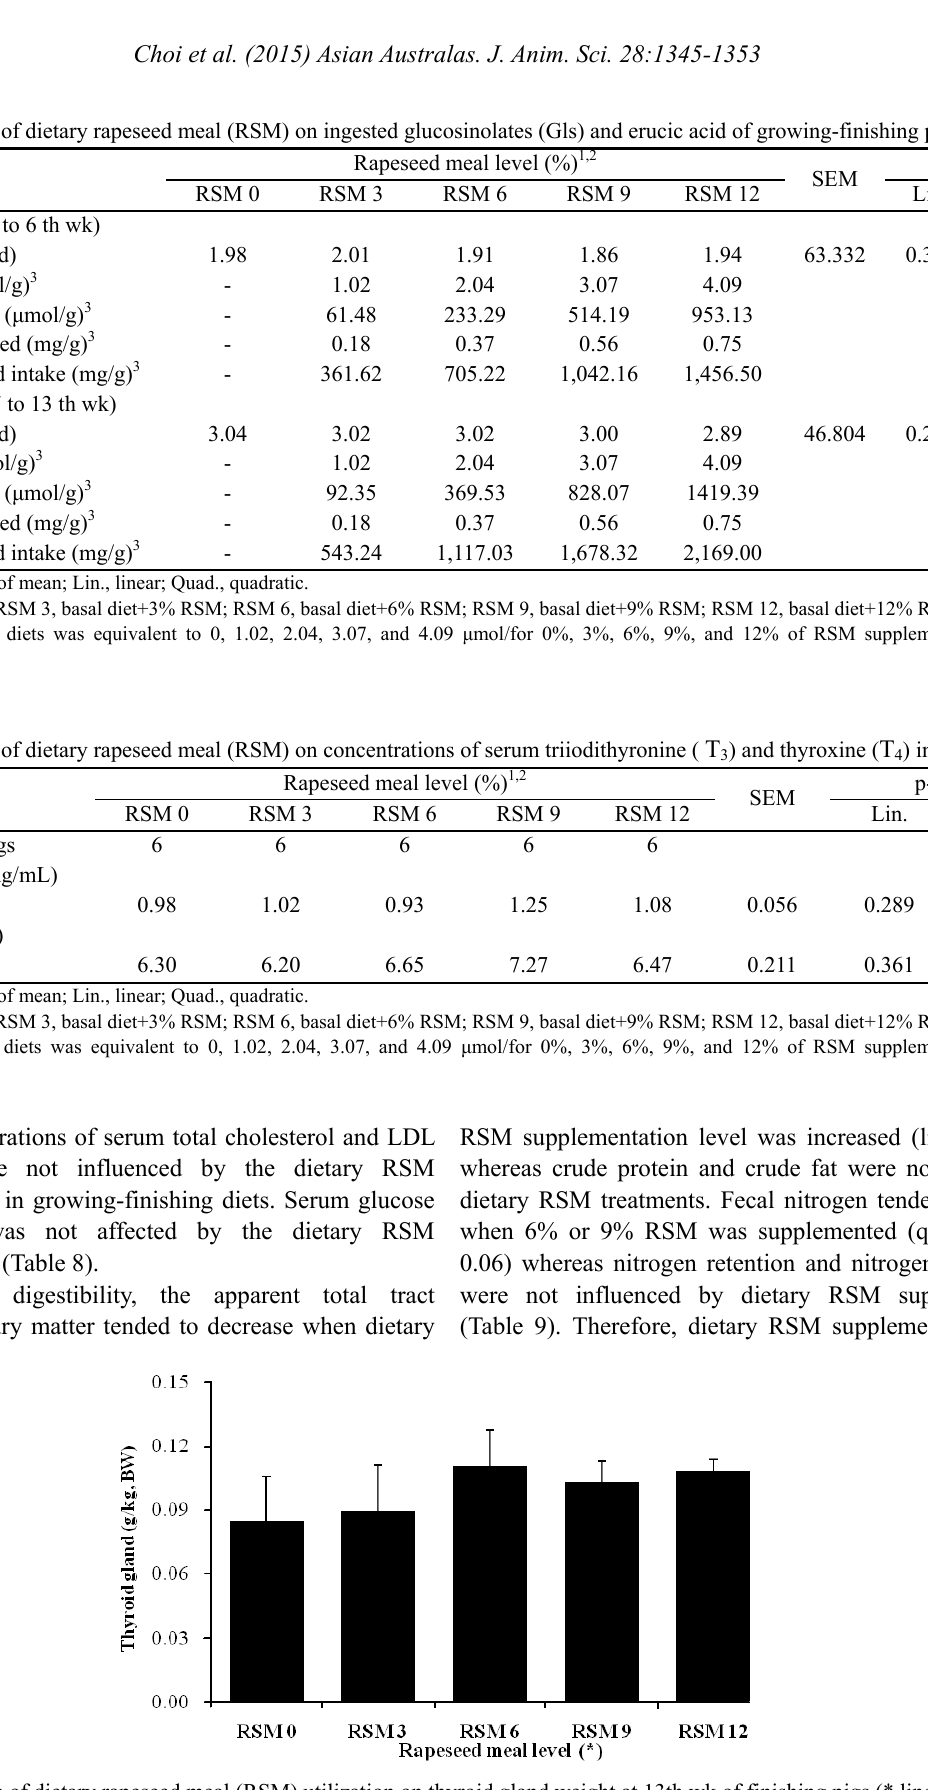
Figure 1. Influence of dietary rapeseed meal (RSM) utilization on thyroid gland weight at 13th wk of finishing pigs (* linear,